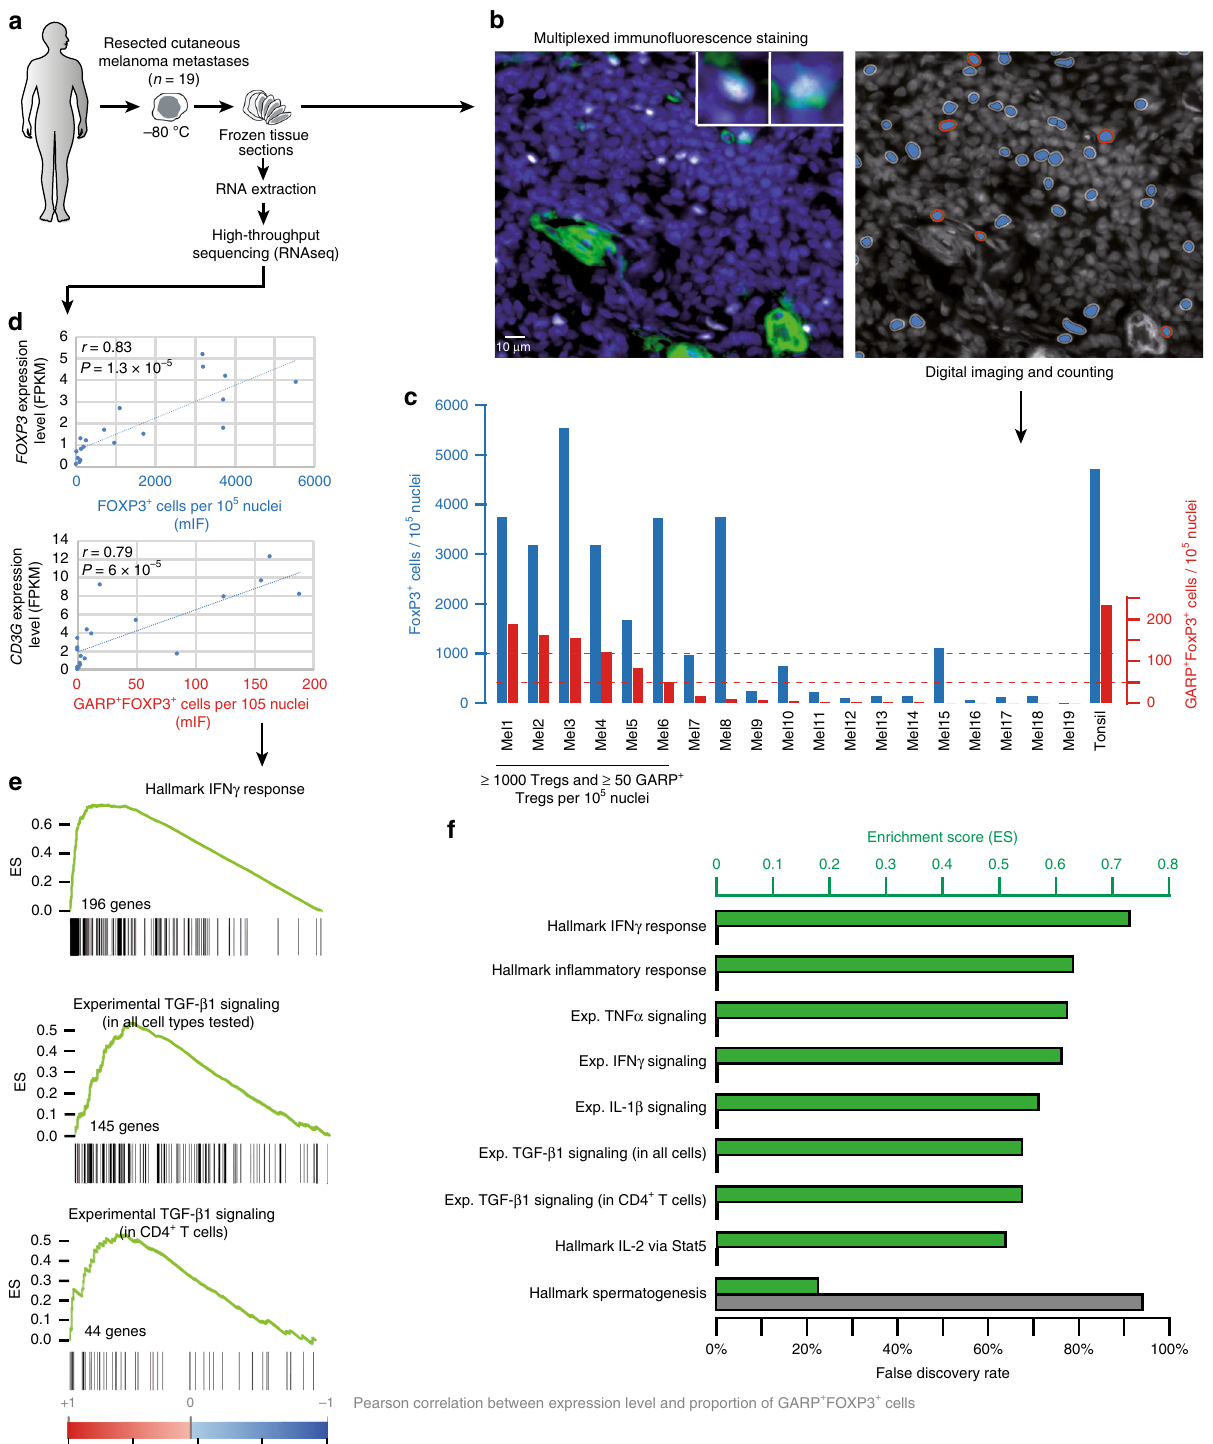
only blocks TGF- β 1 emanating from GARP-expressing cells such as Tregs, whereas anti-TGF- β neutralizes activity of all three TGF- β 1, β 2, and β 3 isoforms, regardless of their cellular source. Our data suggest that blocking only the TGF- β 1 produced on Treg surfaces with anti-GARP:TGF- β 1 mAbs is suf fi cient to increase the anti-tumor activity of PD-1/PD-L1 targeting, while exerting less undesired effects on the tumor microenvironment than that induced by broad blockade of all TGF- β activity.